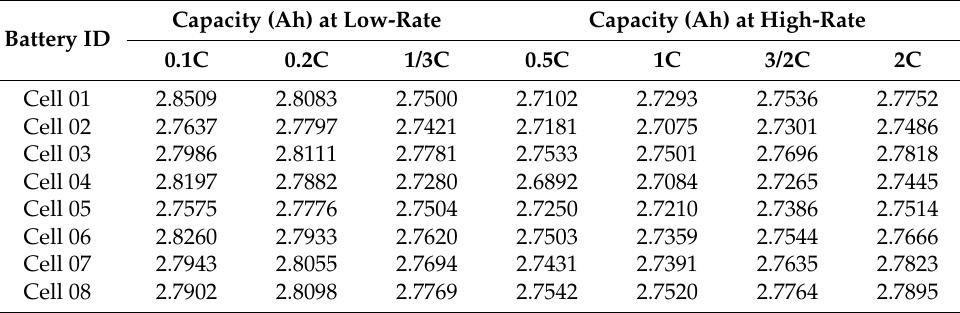
Table 1. The discharge capacity at different C-rates.